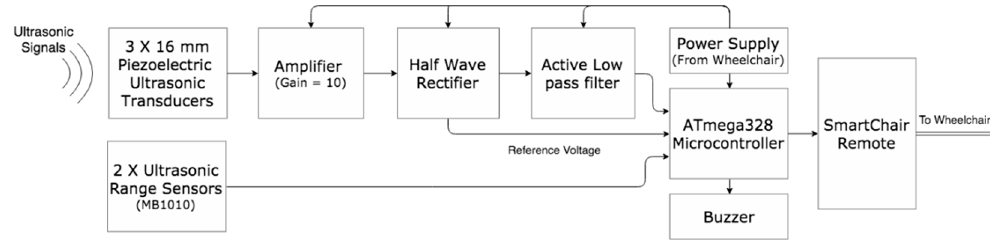
Figure 9. Receiver module hardware block diagram.